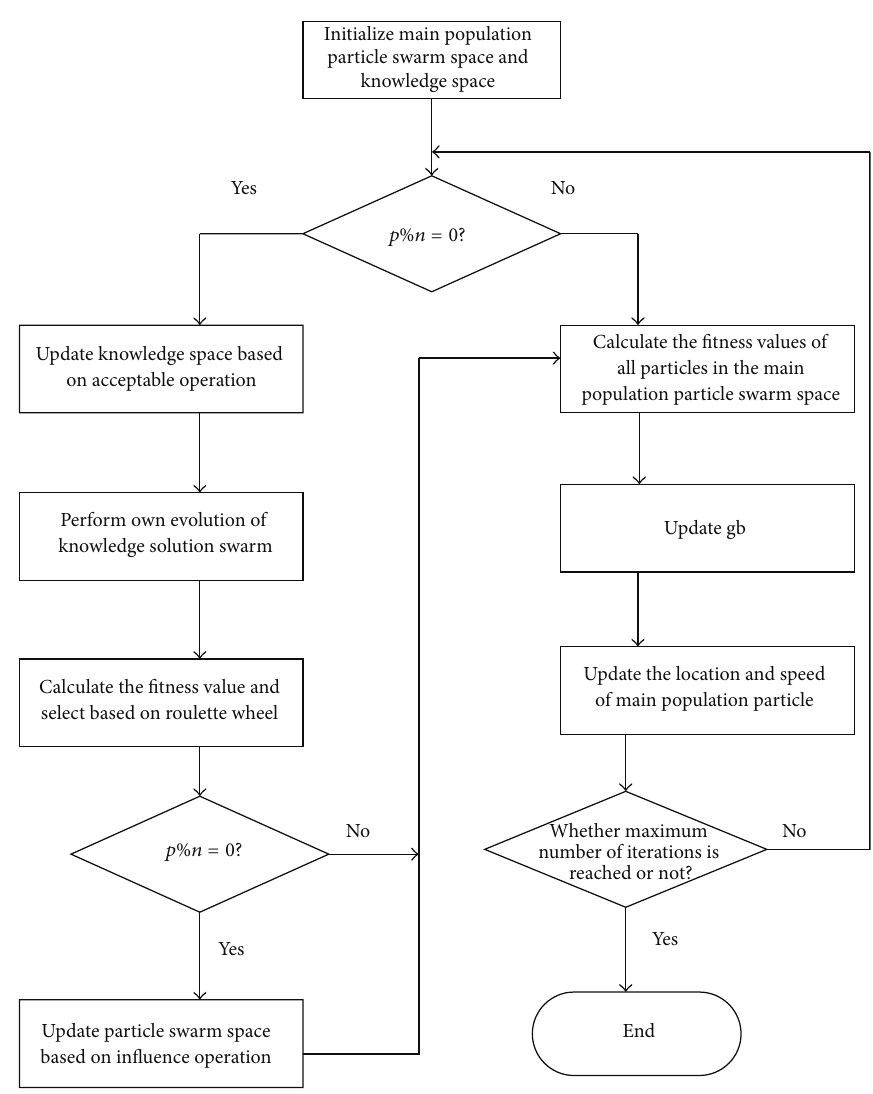
Figure 3: The flow chart of PSOCA